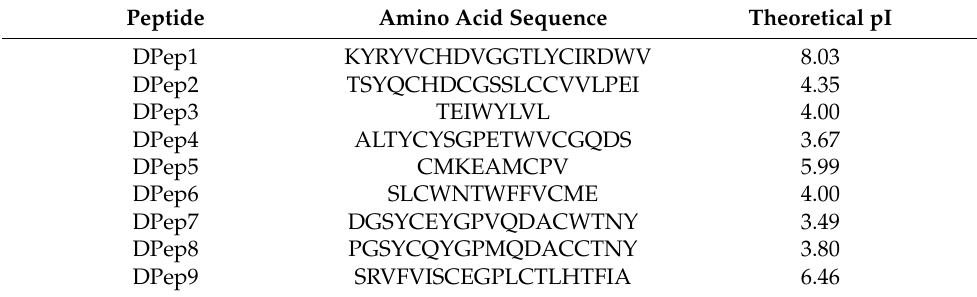
Table 1. Amino acid sequences of DPep1 peptide and PvP selectants.